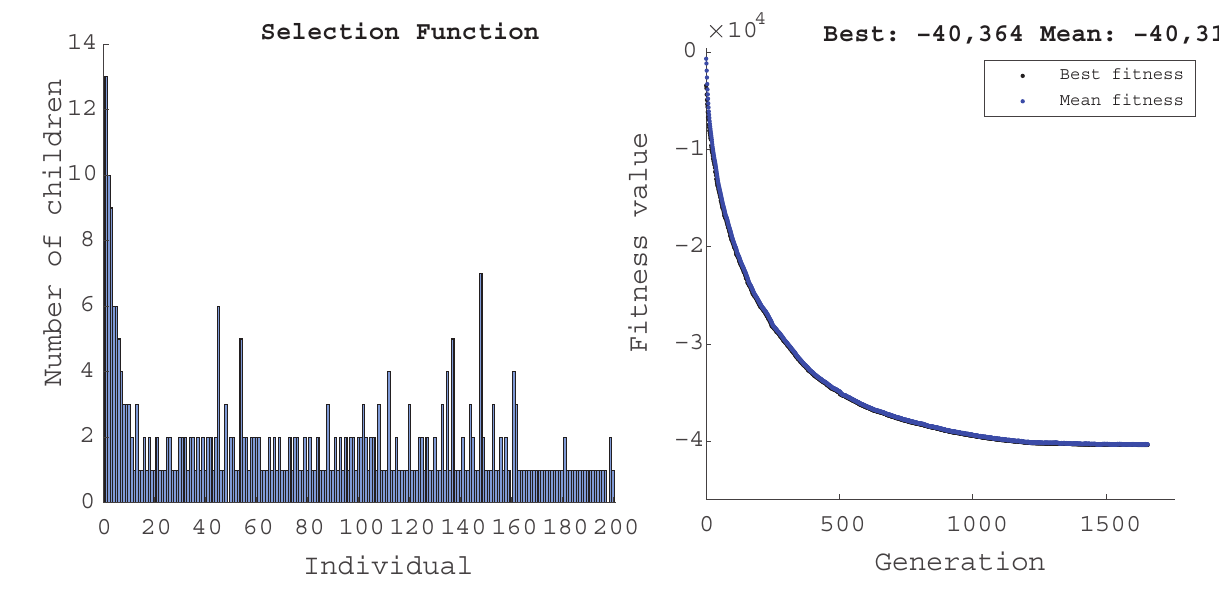
Selection Function